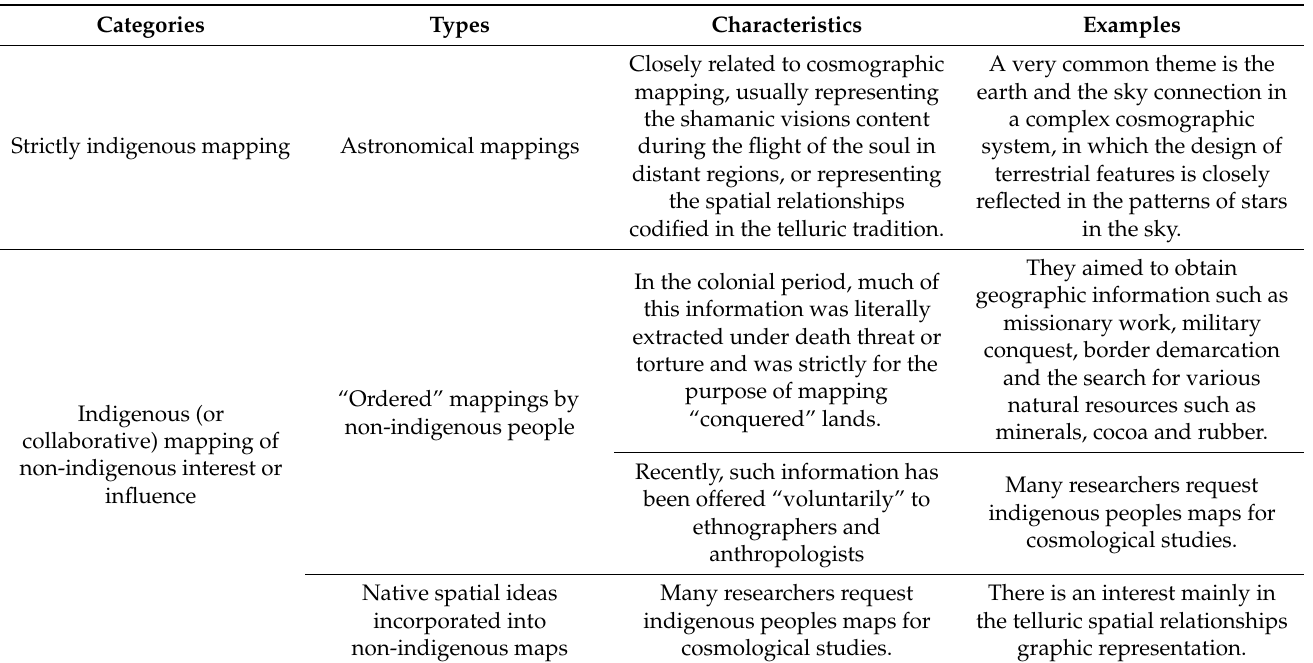
Table 1. Types of indigenous mapping from Whitehead Source: Elaborated by the author from Whitehead